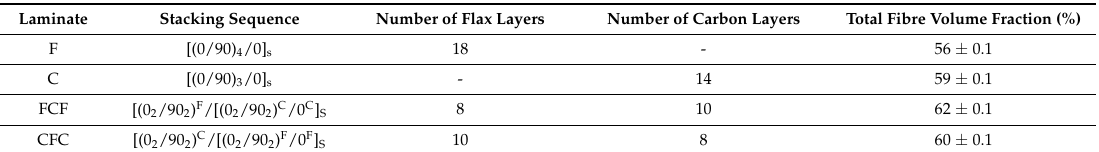
Table 6. The configurations for the carbon–basalt fiber hybrid composites study [36]. (Reproduction permission obtained).